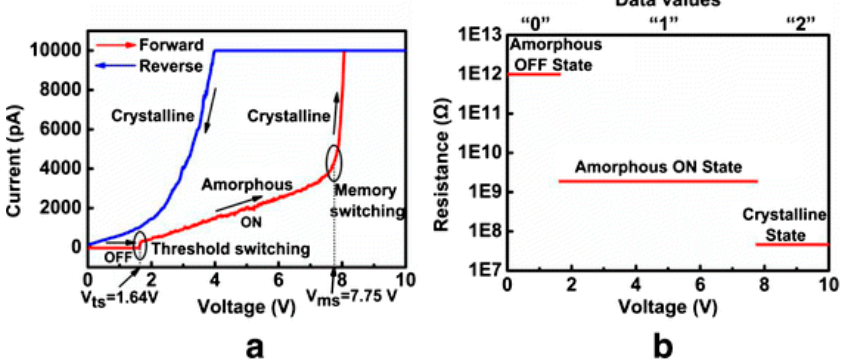
Figure 22. ( a ) Current-voltage spectrum of amorhous GST thin film measured in the range of 0–10 V with C-AFM. ( b ) the corresponding resistance of the amorphous OFF state, amorphous ON state and crystalline state. Reproduced with permission from [52]. Copyright Iop Science, 2015.